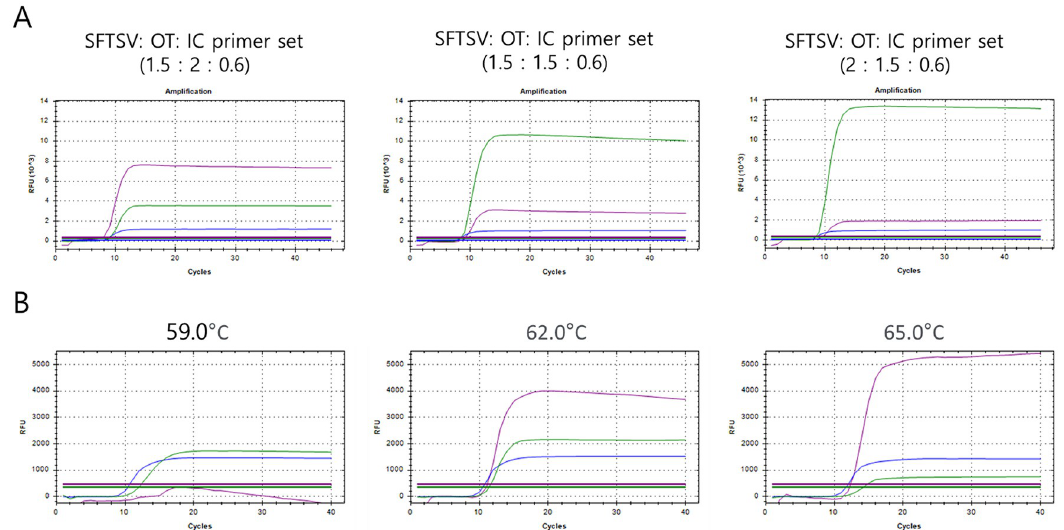
Fig 1. Optimization of the multiplex SFTSV/OT/IC LAMP primer set. (A) Different concentration ratios of SFTSV, OT, and IC primer sets (1.5:2:0.6, 1.5:1.5:0.6, and 2:1.5:0.6, respectively) for SFTSV, OT, and IC plasmid mixtures (1:1:1). (B) Temperature gradient tests (59–65˚C) of the multiplex SFTSV/OT/IC LAMP assay.